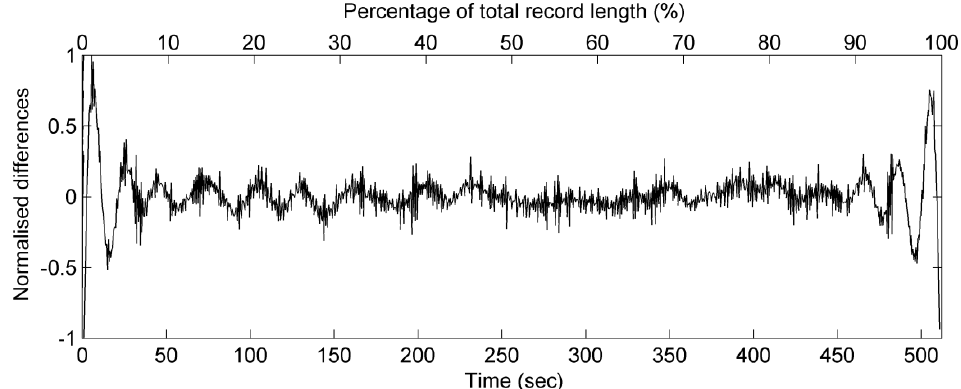
Figure 4. The normalised differences between the synthetic sea surface elevations and the observational sea surface